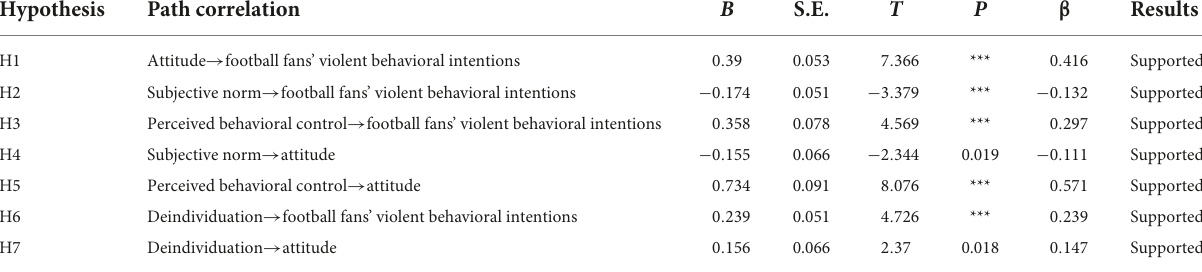
TABLE 6 The path coefficients test of the hypothesis model.